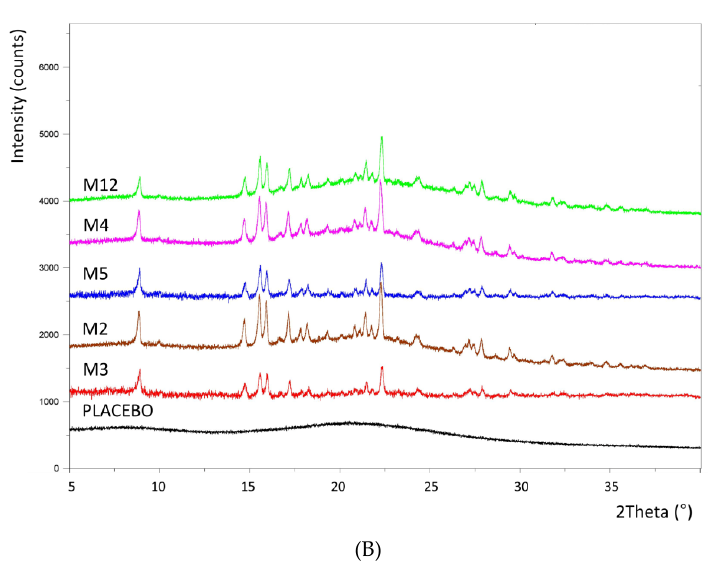
Figure 5. X-Ray Powder Diffraction (XRPD) patterns of ( A ) pure zidovudine (ZVD), placebo microparticles with chitosan glutamate crosslinked with β -glycerophosphate (gCS:CF 2:1, w/w ), and crosslinking ratio (M2 2:1; M3 1:1; M4 3:1; M5 2:1; M12 1:1, w/w ).